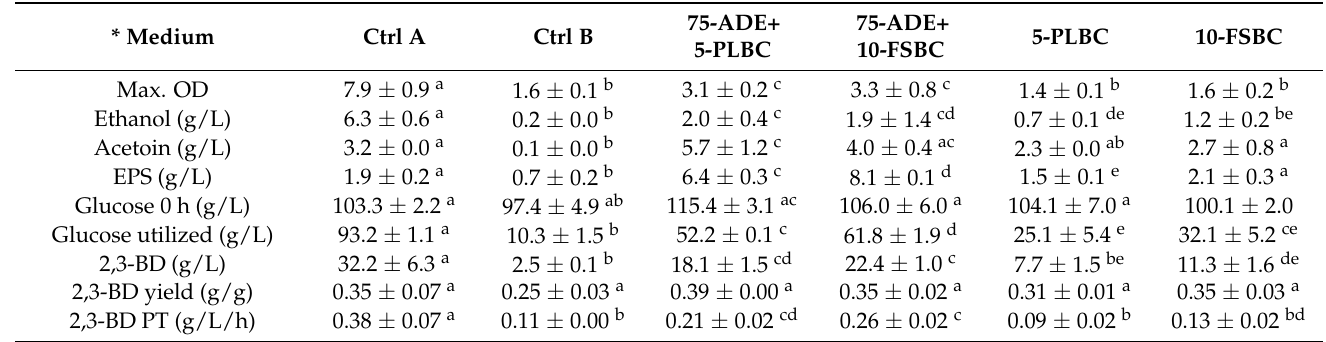
Table 6. Fermentation parameters of P. polymyxa grown in treatment C media containing ~115 g/L glucose supplemented with anaerobic digestion effluent (ADE) and poultry liter biochar (PLBC) or forage sorghum biochar